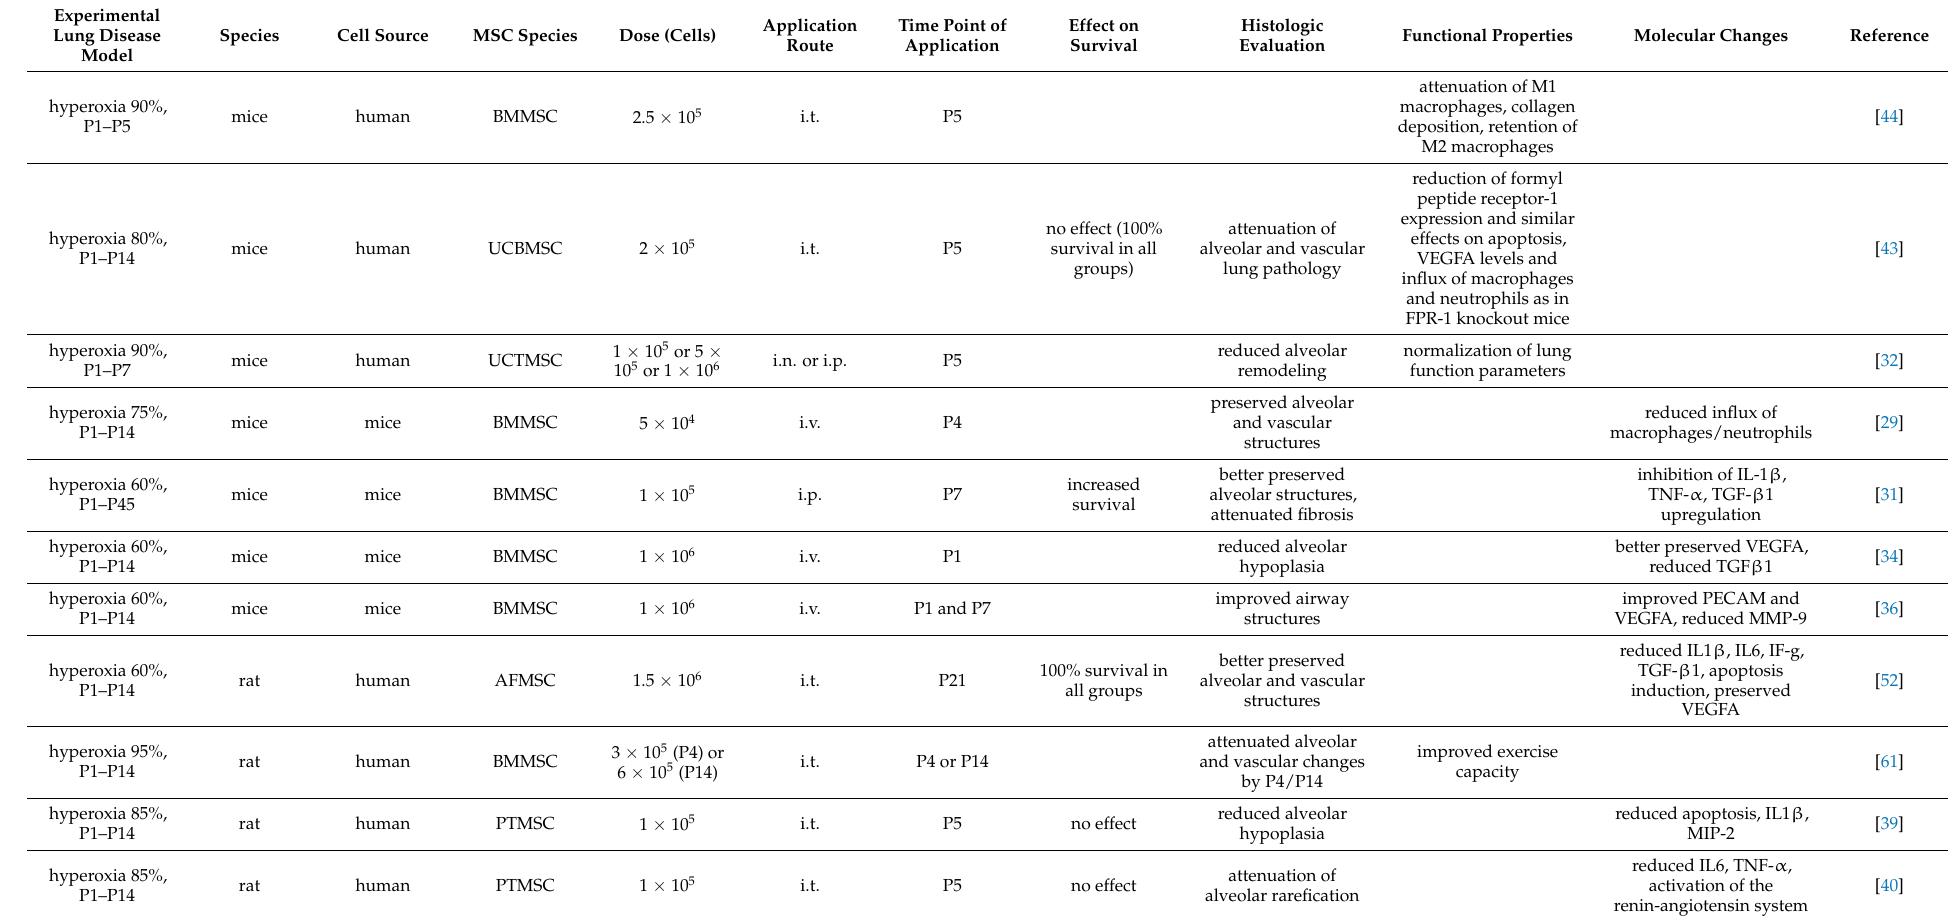
Table 2. Therapeutic actions of mesenchymal stem cells (MSC) to prevent or treat BPD in the hyperoxia rodent